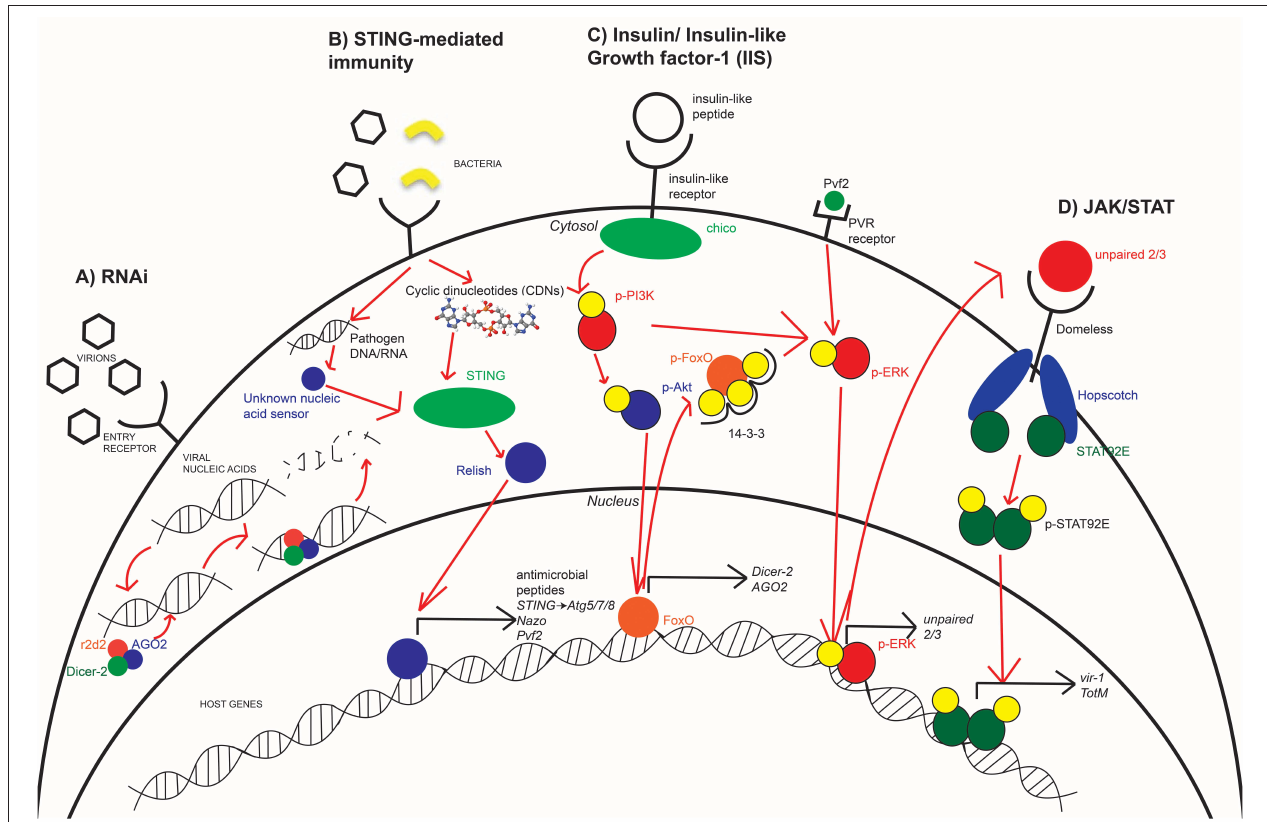
FIGURE 2 | Innate immune antimicrobial pathways are conserved in arthropods. Insects utilize RNAi (A) , STING-mediated immunity (B) , and JAK/STAT signaling (D) in order to effectively respond to various arboviruses at different stages of infection. The IIS pathway (C) is an important mediator in host immunity as it regulates which immune responses are active or suppressed. During times of starvation, RNAi is more active while the bloodmeal provides the needed insulin to suppress RNAi and activate JAK/STAT. STING-mediated immunity has not yet been directly linked to IIS but may be affected by broader nutritional signaling. Each of these pathways, to varying degrees, are conserved in fly, mosquito, and human systems with different efficiencies in responding to viral infection.